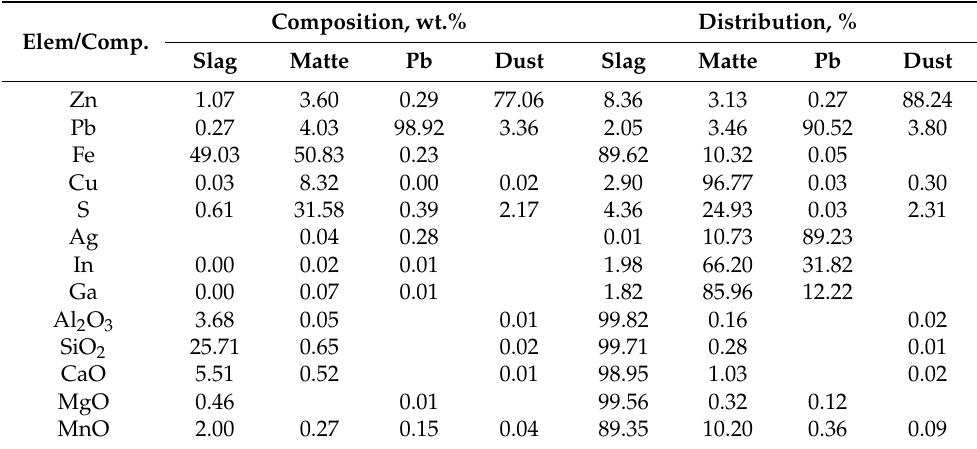
Table 11. Submerged DC arc furnace smelting of 83/13_S/4_C. Composition, wt.% Elem/Comp.